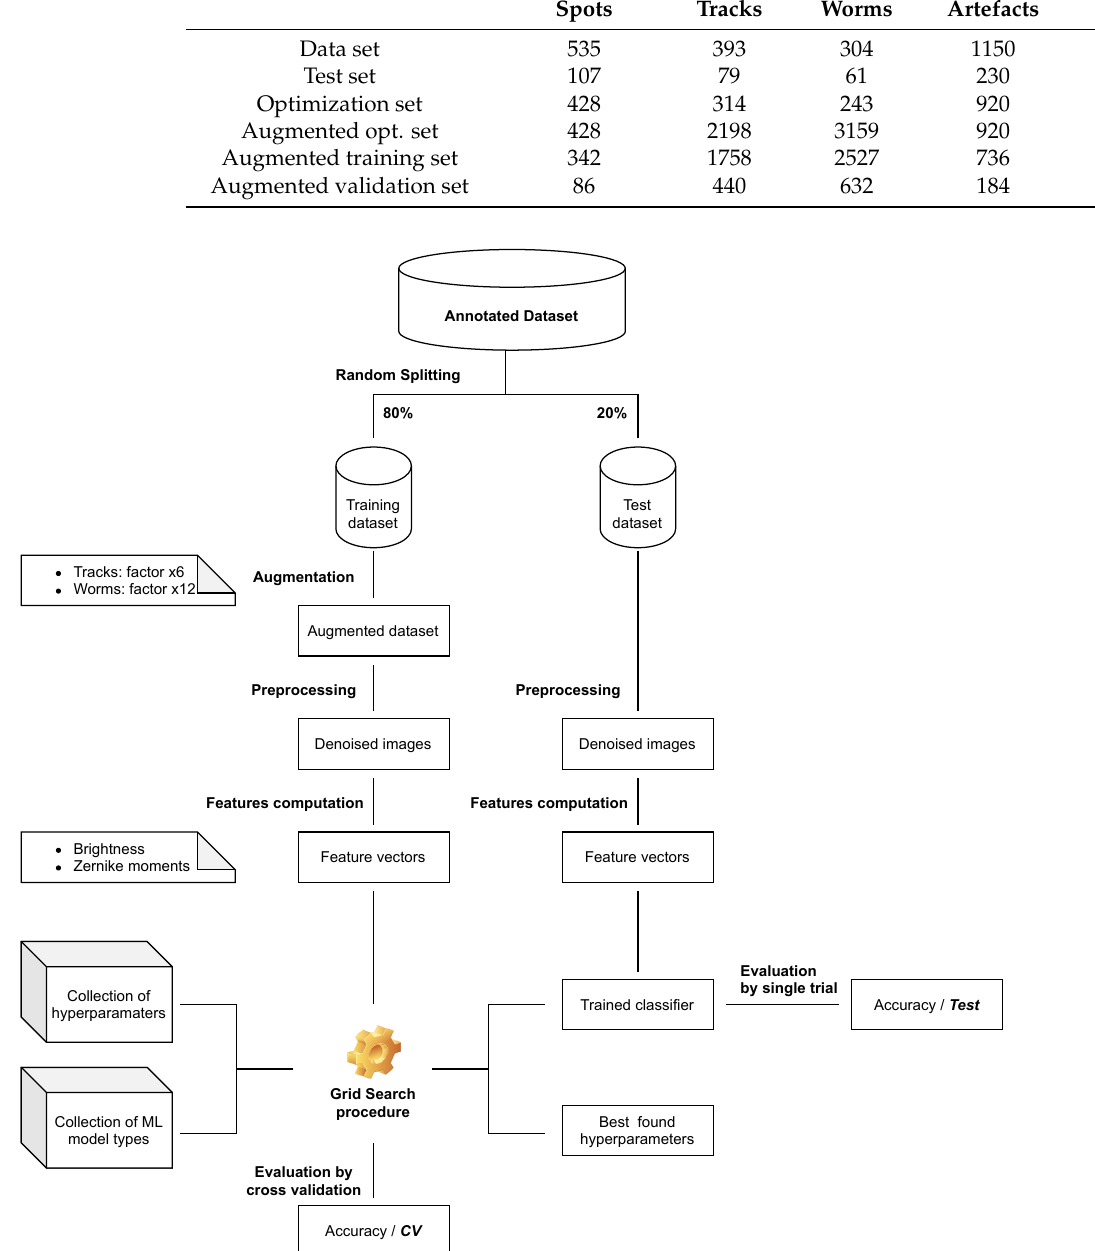
Figure 9. Descriptive scheme for the first phase of computation: parametric optimization of selected classifier models. The monochromatic image obtained during these transformations is the basis for computing the the feature vector (Sections 2.4, 2.5 and 3.3). For this purpose, a set of features relating to the shape/morphology of the signal (a set of Zernike moments